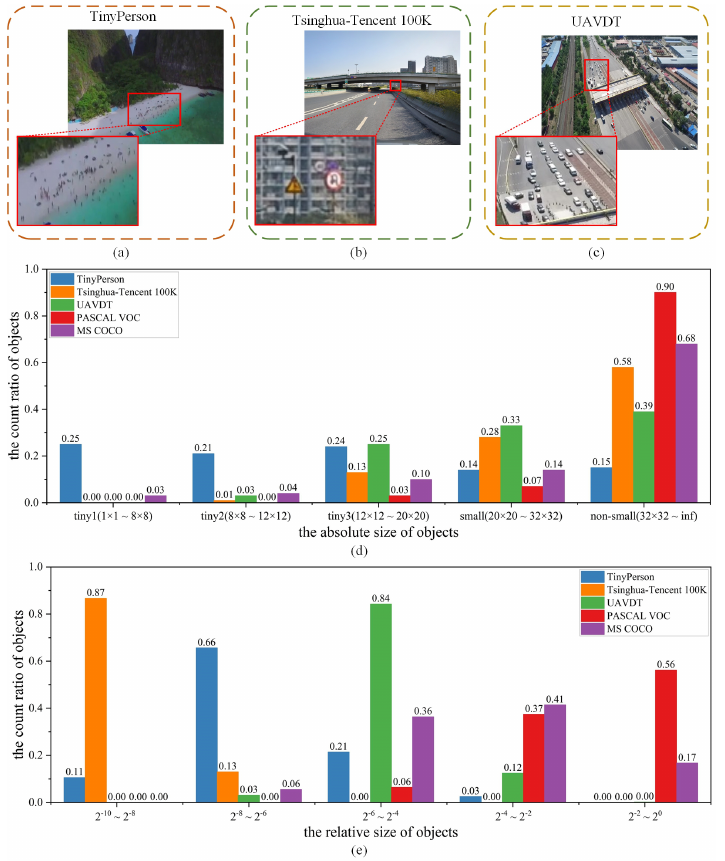
Figure 1. Dataset visualization analysis. ( a – c ) are sample images of TinyPerson, Tsinghua–Tencent 100K, and UAVDT benchmark datasets, respectively. ( d , e ) are the statistical histograms of the absolute and relative size of objects in the